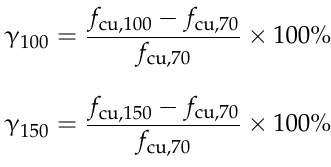
Table 4. Experimental values of peak compressive stress of recycled aggregate concrete with different aggregate substitution ratios (unit: MPa). Cube’s Side Length